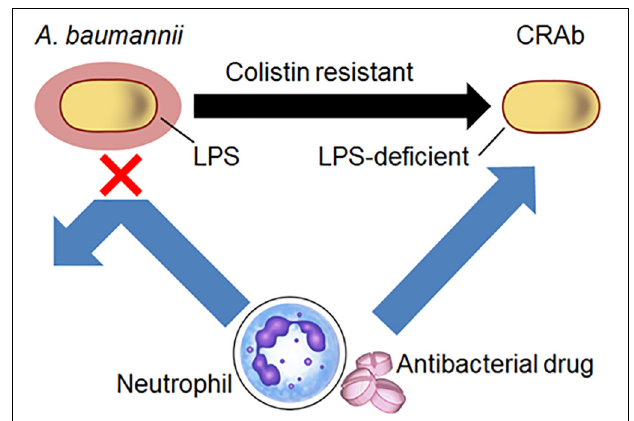
FIGURE 7 | Schematic diagram of the study. Acinetobacter baumannii acquire resistance to colistin by LPS deficiency. Neutrophil-derived lysozyme and antibacterial drugs such as β -lactam were killed by LPS-deficient A. baumannii strains.